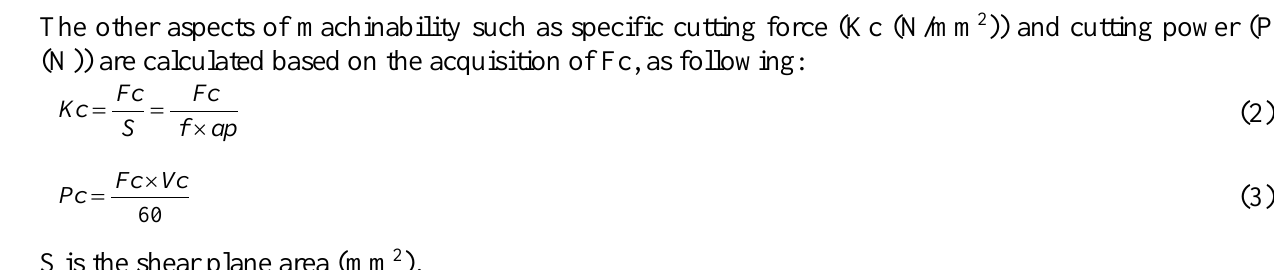
Fig. 2. Sample of acquisition from “Dynoware”